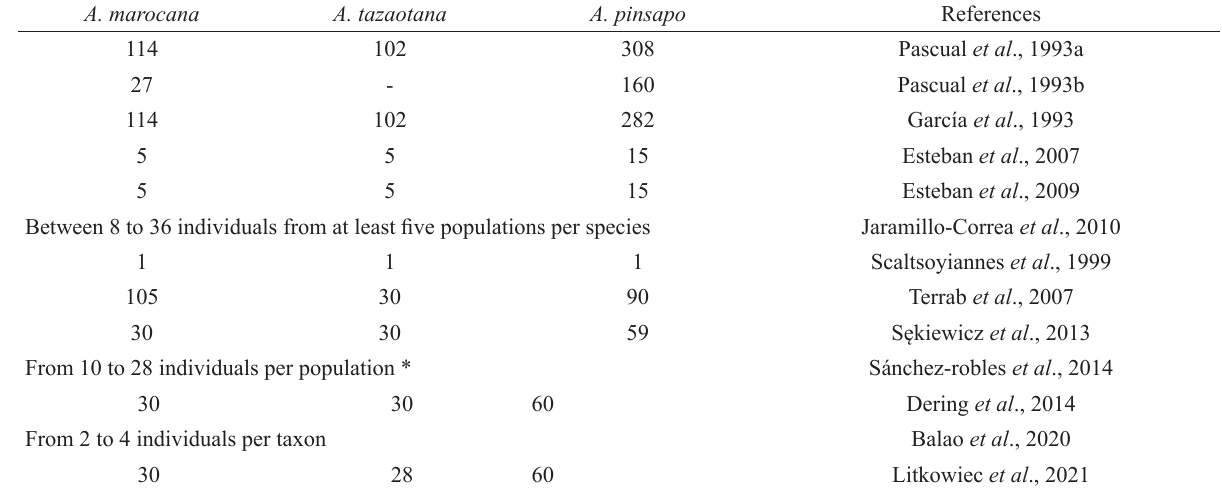
Table 3. Number of individuals sampled for Moroccan (Talassemtane and Tazaout) and Spanish populations; asterisk indicates the number of populations, 3, for A. marocana , 1, for A. tazaotana and 3, for A.